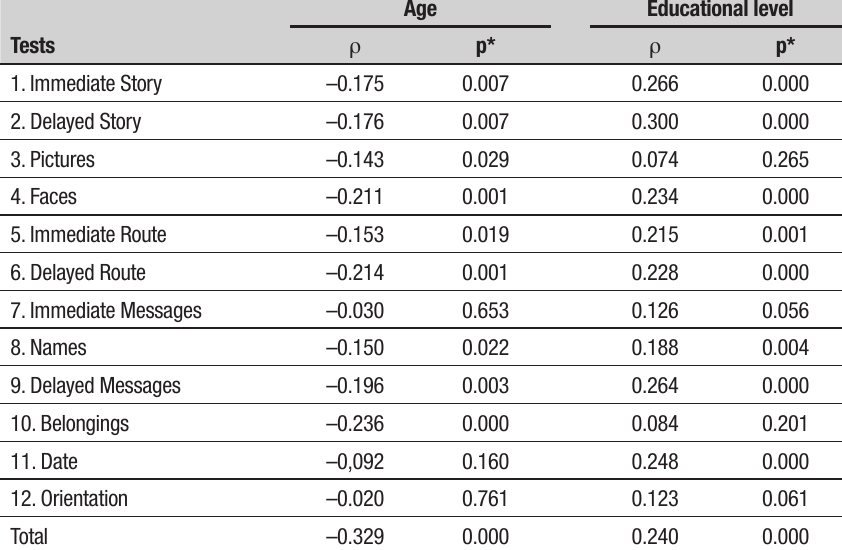
Table 2. Correlation of tasks with age and educational